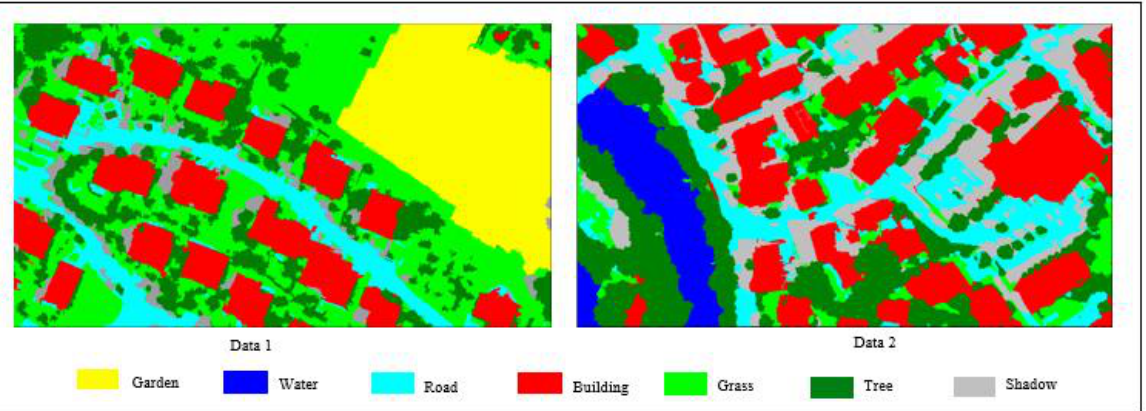
Figure 6. Classification results for the two images